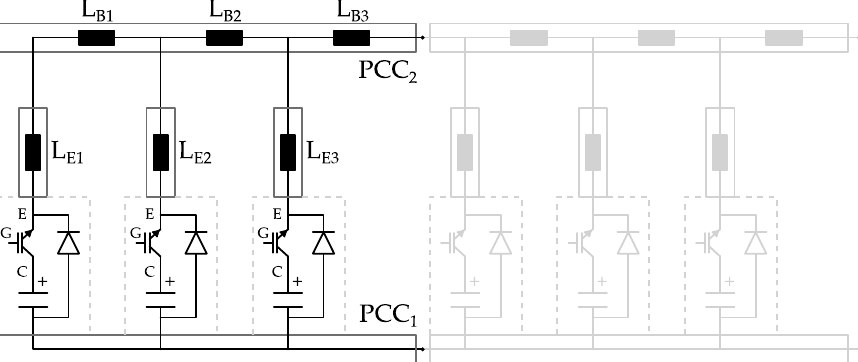
Figure 11. Schematic drawing of the circuitry of a PEBC module package with connection to the neighboring package (greyed out) at PCC 1 (common ground) and PCC 2 (common output). neighboring package (greyed out) at PCC 1 (common ground) and PCC 2 (common